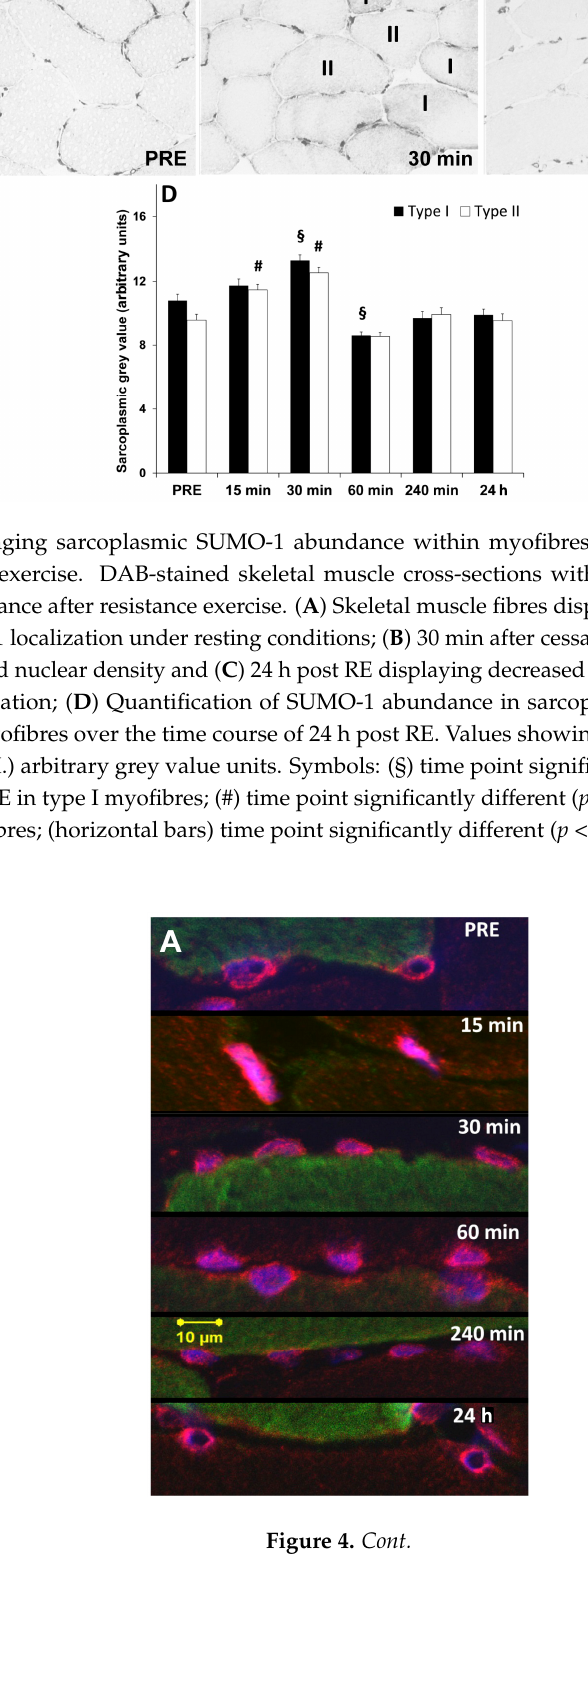
Figure 4. Cont. Figure 4.